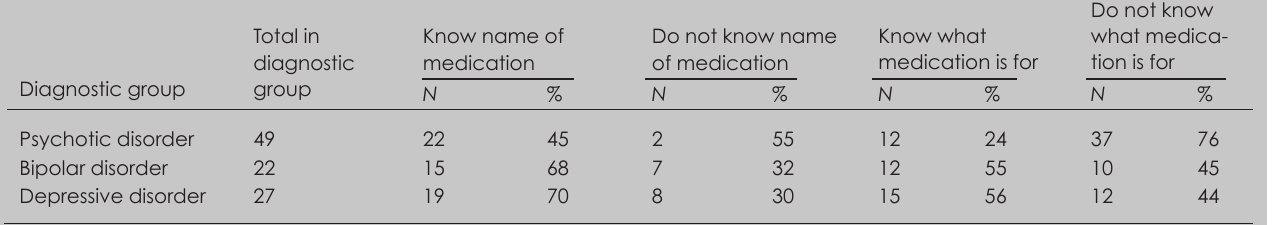
Table IV. Diagnostic group and knowledge of medication